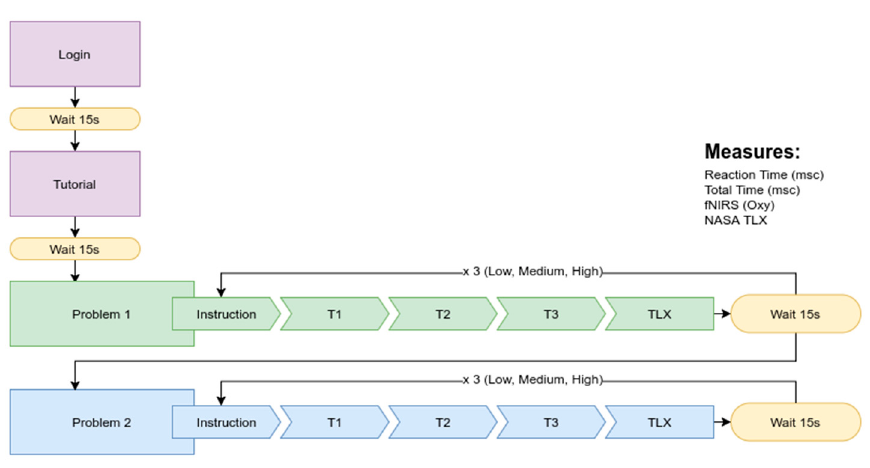
Figure 4. Spatial navigation transfer (SNT) game tasks and measures.